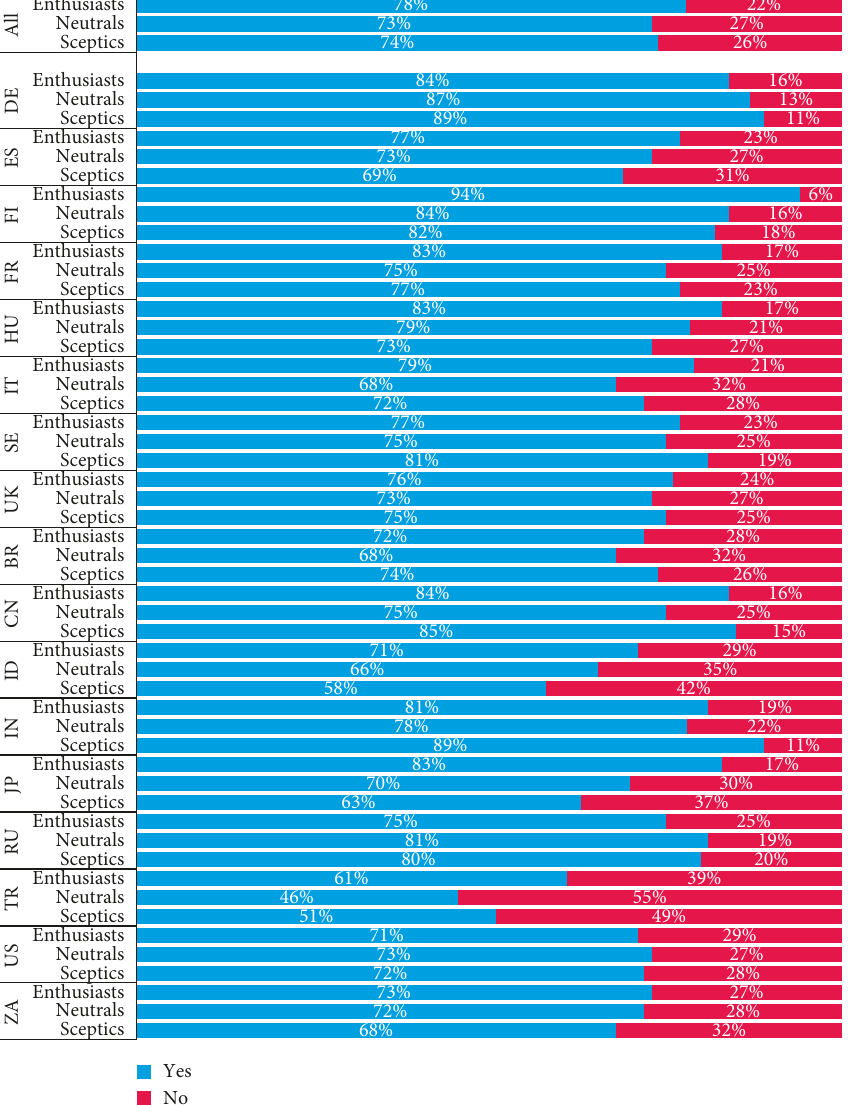
Figure 4: Percentage values of Enthusiasts, Neutrals, and Sceptics differing in their awareness of automated cars before taking part in the questionnaire